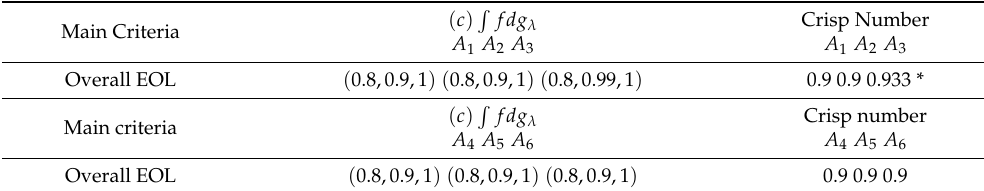
Table 8. The comprehensive evaluation value of EOL options with respect to the cabinet